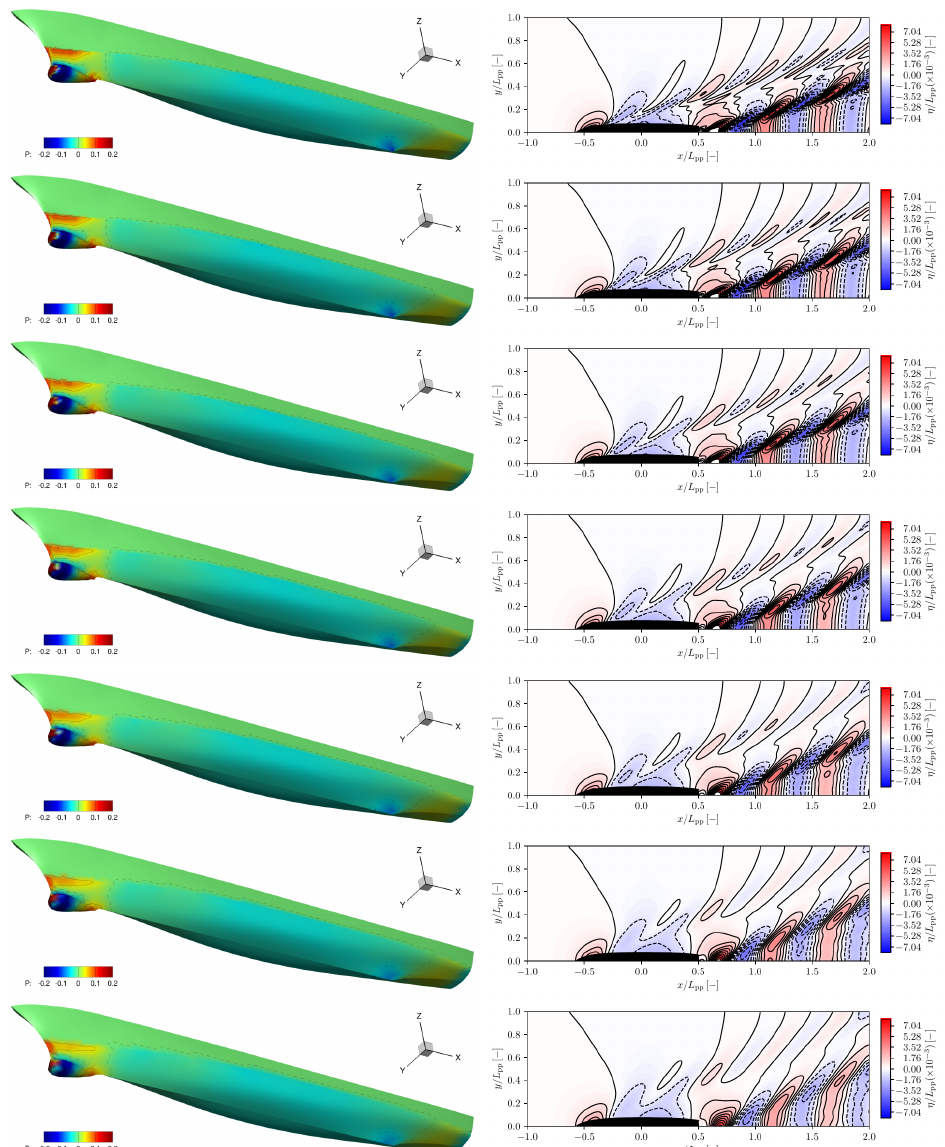
Figure 3. Pressure on the hull ( left ) and free-surface elevation ( right ) of the original hull varying the grid refinement: from top to bottom highest (G1) to lowest fidelity